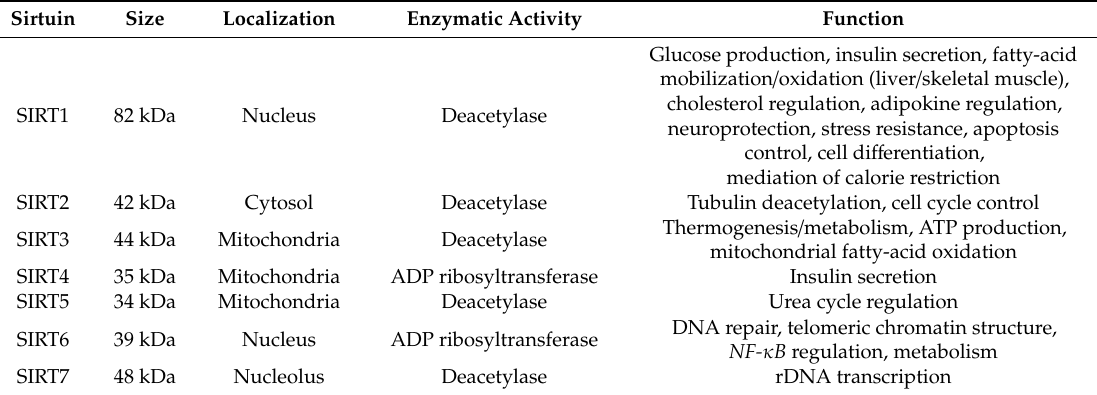
Table 1. SIRT 1–7 characterization: size, localization, enzymatic activity and